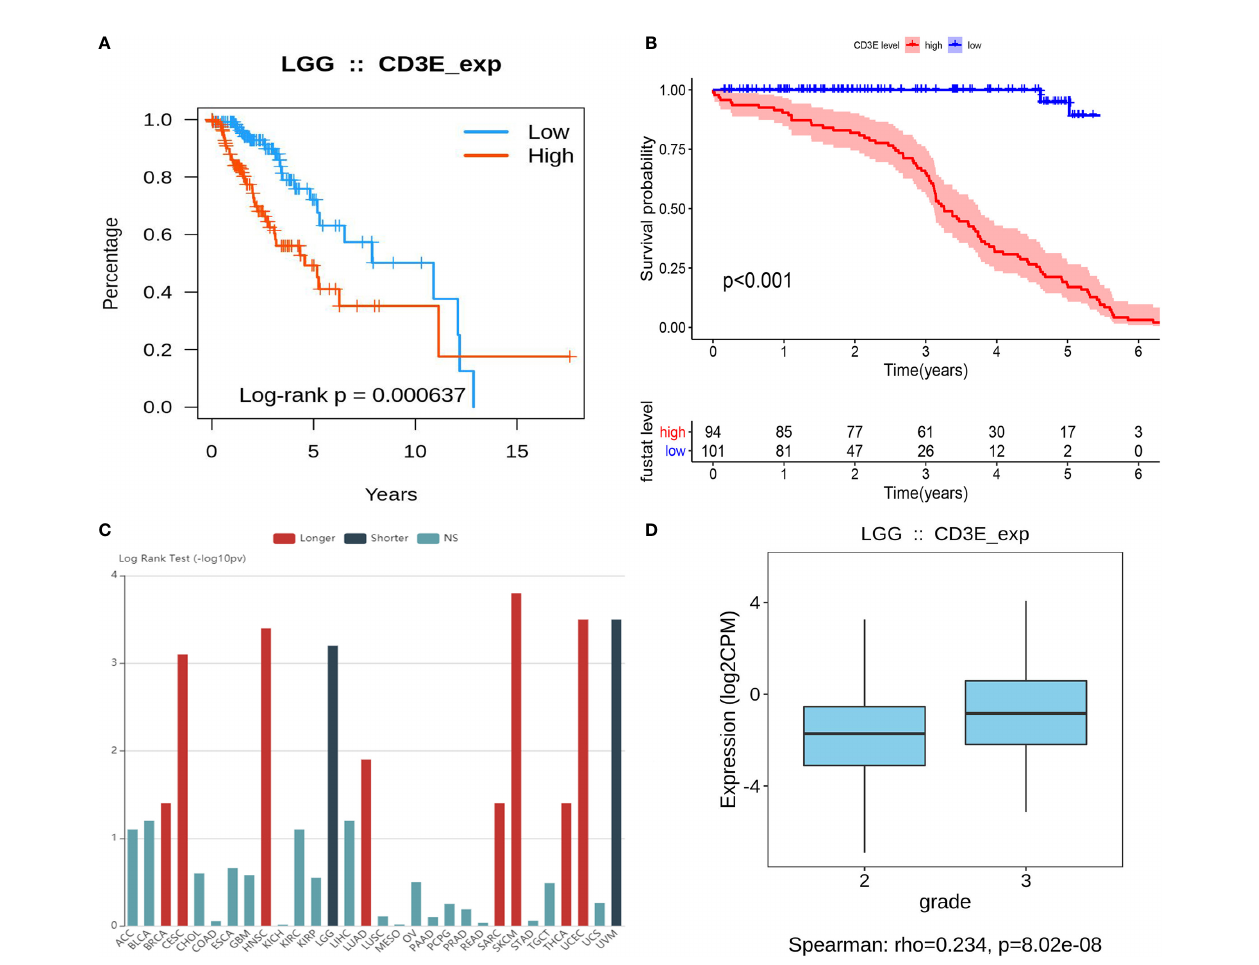
FIGURE 8 | Relationship between CD3E expression and survival of LGG patients (A) Relationship between CD3E expression and survival of LGG patients in the TCGA database ( P = 0.000637). (B) Relationship between CD3E expression and survival of LGG patients in the GSE database ( P < 0.001). (C) CD3E might have completely opposite prognostic effect of CD3E in gliomas than that of most other tumors. (D) The relationship between CD3E expression and survival of LGG